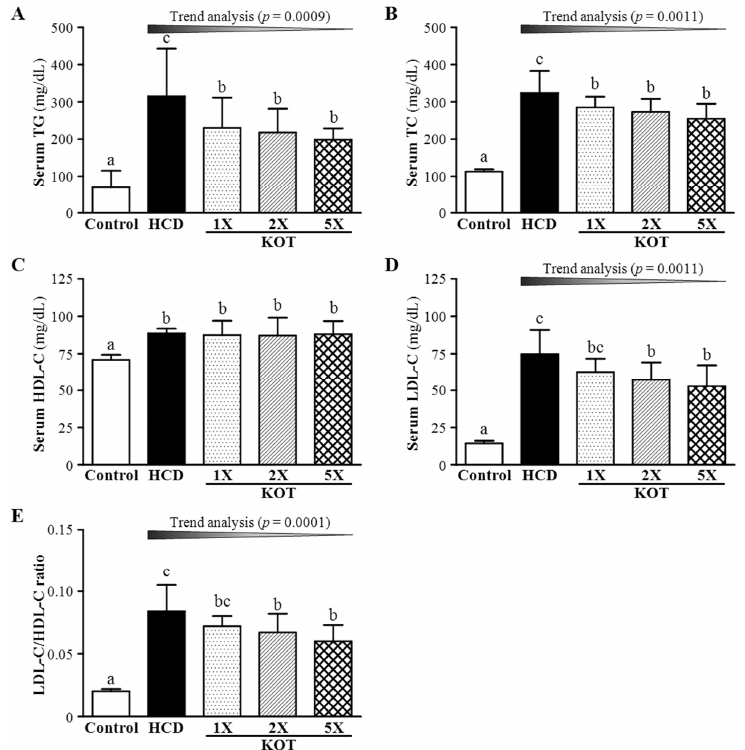
Figure 3. Effect of six-week supplementation with KOT on serum levels of triglycerides (TG) ( A ); total cholesterol (TC) ( B ); high-density lipoprotein cholesterol (HDL-C) ( C ); low-density lipoprotein cholesterol (LDL-C) ( D ); and LDL-C/HDL-C ratio ( E ) in hamsters. Data are mean ˘ SD